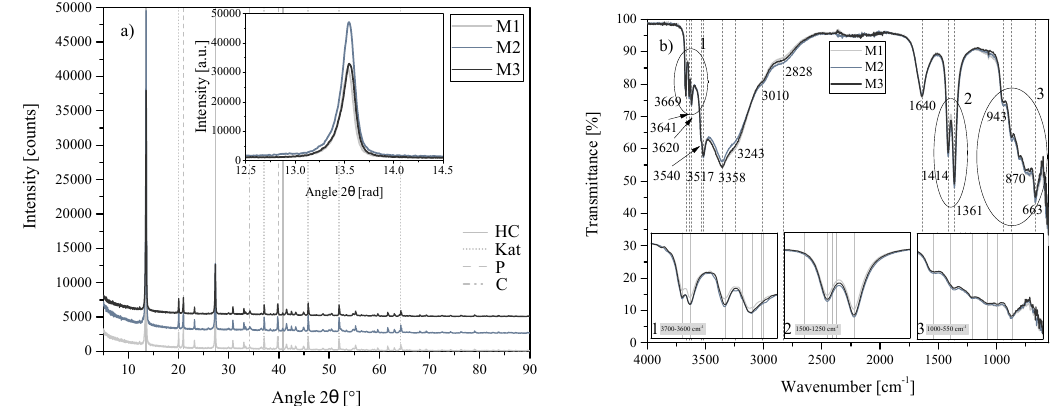
Figure 19. ( a ) XRD results of the mixing series M1, M2 and M3 between 5 ◦ 2 θ and 90 ◦ 2 θ . Each scan is y-shifted by 2500 counts. The inset depicts the primary LDH peaks and change in position. HC = hydrocalumite, Kat = katoite, P = portlandite and C = calcite. ( b ) FTIR-ATR scans of the mixing series M1, M2 and M3 between 4000cm − 1 and 550cm − 1 . The three insets show the regions: ( 1 ) 3700cm − 1 – 3600cm − 1 , ( 2 ) 1500cm − 1 – 1250cm − 1 , ( 3 ) 1000cm − 1 – 550cm − 1 in detail. Dashed and solid grey lines indicate the maxima of vibrations. M1 = 500 rpm, WS2 = 750 rpm and WS3 = 1000 rpm. Rietveld refinement further confirmed the similarity between these three reaction outcomes.